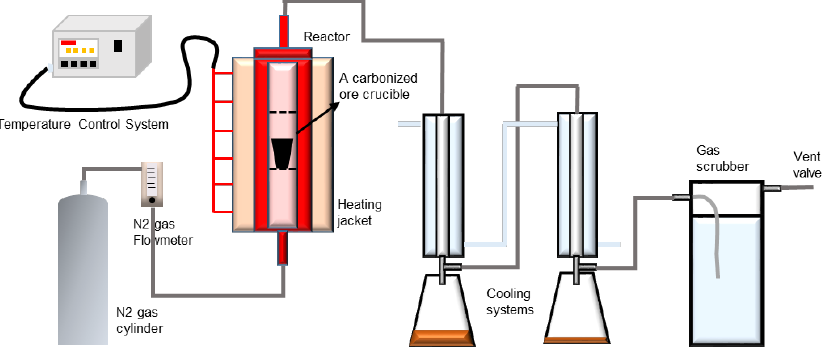
Figure 1. Scheme of the apparatus for carbonization process .